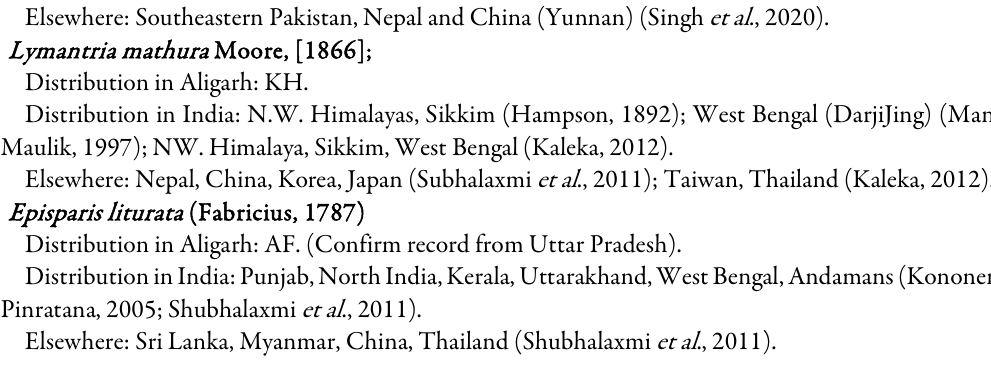
Table 2. Summary of Erebidae moths recorded during the study S.